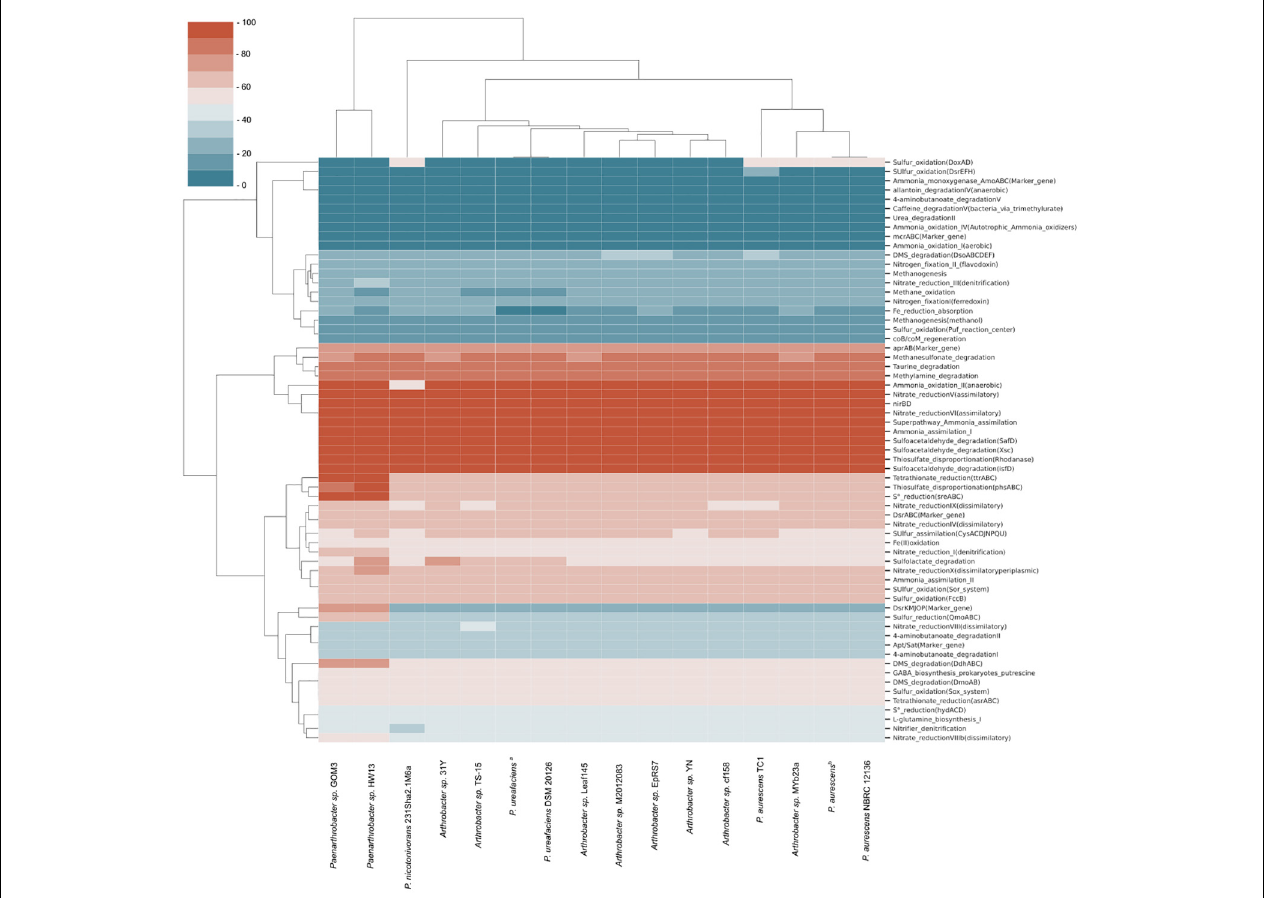
FIGURE 2 | Metabolic completeness of C, O, N, S, and Fe cycles of strains related to pangenomic analysis. The most complete pathways in biogeochemical cycles are marked in red, and the least complete pathways shift to blue. P. ureafaciens a corresponds to RefSeq assembly accession GCF_006538985, and P. aurescens b corresponds to RefSeq assembly accession